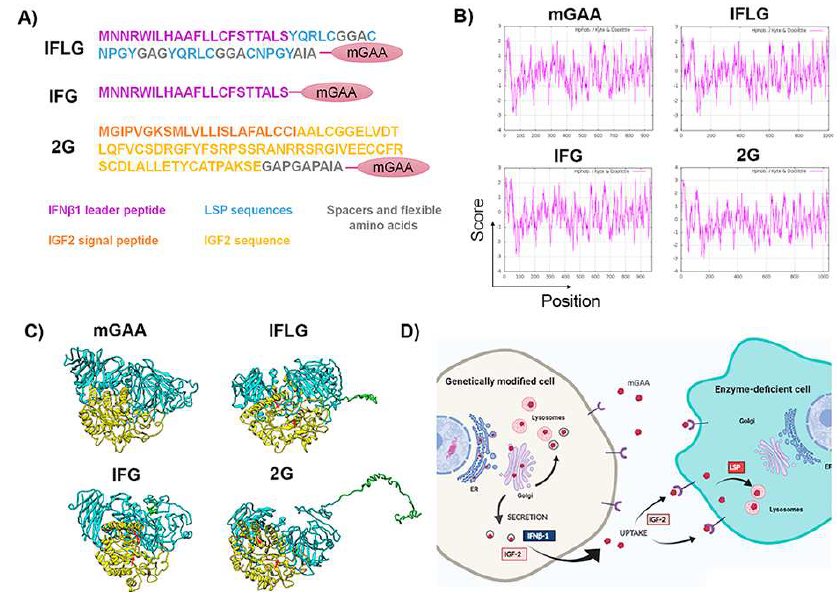
Figure 3. Design of different chimeric mGAA proteins to increase their secretion and lysosomal uptake. ( A ) Designs of different optimised chimeric mGAA. IFLG corresponds to the leader peptide of IFN β 1 and LSP coupled to mGAA. IFG refers to the leader peptide of IFN β 1 coupled to mGAA, and 2G corresponds to IGF2 coupled to mGAA. ( B ) Hydrophobicity pattern of mGAA, IFLG, IFG and 2G using the Kyte–Doolittle scale. The plots show hydrophilic and hydrophobic regions of native mGAA, IFLG, IFG and 2G. Values above 0 correspond to hydrophobic regions, and those below 0 correspond to hydrophilic ones. The addition of IFLG and 2G to mGAA creates a more hydrophilic region in the N-terminus than the native one. IFG has a similar tendency to the native one, due to the hydrophilicity of the leader peptide. ( C ) Three-dimensional structure prediction of optimised chimeric mGAAs by I-TASSER. The optimisations included in mGAA are present in the amino terminus of the global structure (coloured in green), coupled with the trefoil domain of mGAA, non-interfering with the catalytic domain (catalytic domain in yellow, red arrows pointing the two catalytic asparagine). ( D ) Scheme showing the rationale of GAA modifications to improve GT strategies. Created with BioRender.com. Contrary to endogenous GAA, GT-optimised GAAs (opGAA) must be primarily secreted in order to cross-correct as many cells as possible. The leader peptide of the IFN β -1 or IGF-2 will enhance secretion of the different chimeric GAAs. Once opGAA is secreted to the medium, it must be taken up by enzyme-deficient cells to correct GAA deficiency and degrade the accumulated glycogen (cross-correction). IGF-2 and LSP sequences are included to improve uptake and/or lysosomal targeting of secreted